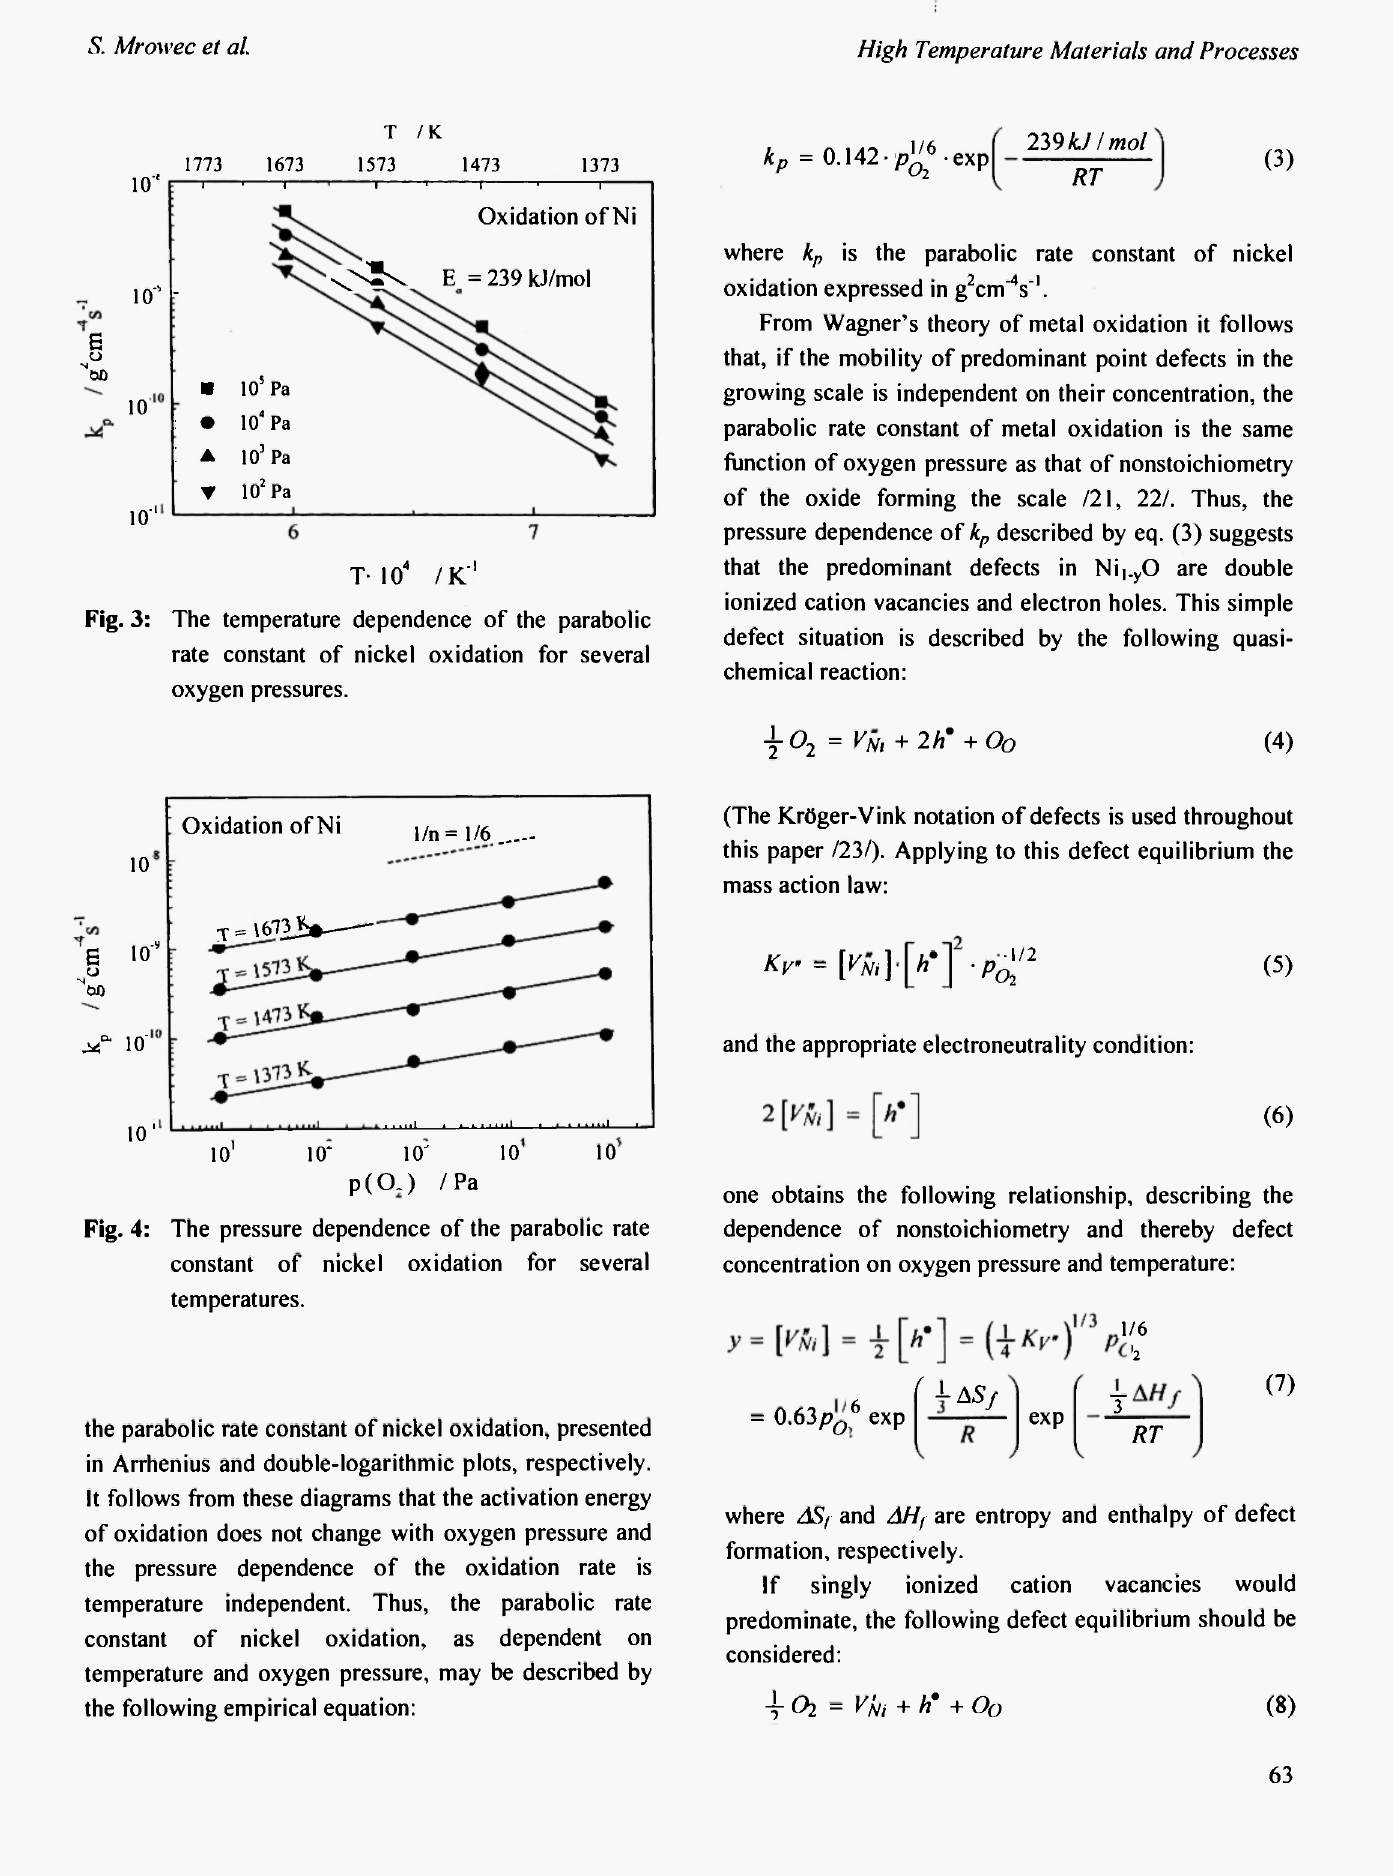
Fig. 3: The temperature dependence of the parabolic rate constant of nickel oxidation for several oxygen pressures.